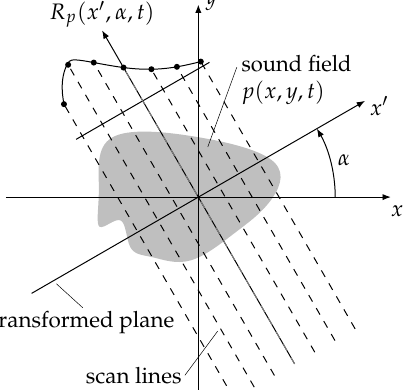
Figure 2. Principle of the Radon transformation.